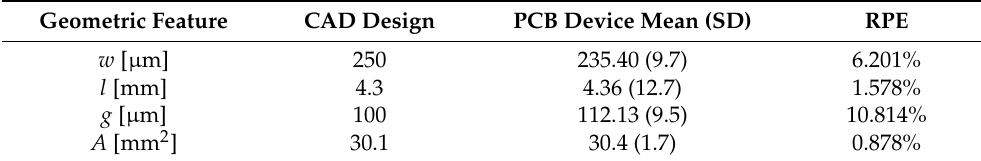
Figure 9. Fabricated IDEAs: ( a ) before and ( b ) after SU-8 deposition. Table 2. Geometrical characterization of the PCB-MEMS device fabricated from laser ablation.